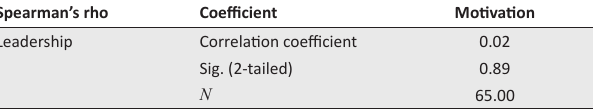
TABLE 7: Correlation analysis between Perceived Leadership Styles and Public Sector